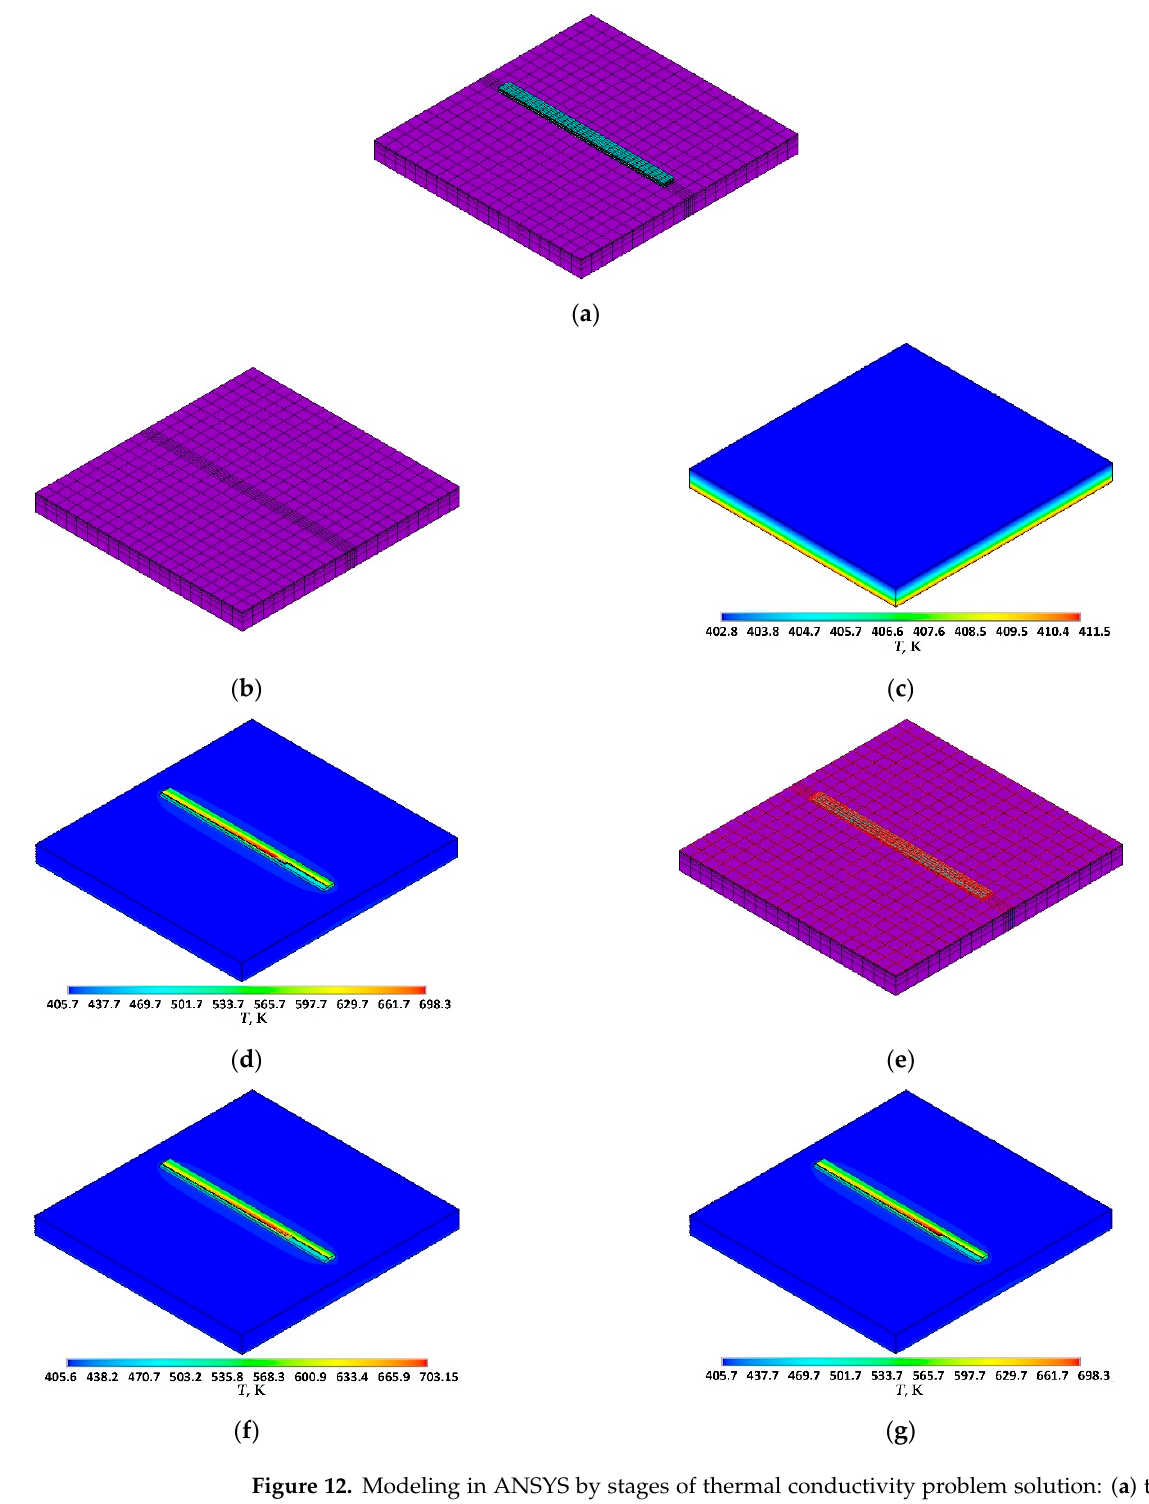
Figure 12. Modeling in ANSYS by stages of thermal conductivity problem solution: ( a ) the finite element model; ( b ) calculated scheme after “killing” the elements; ( c ) initial conditions applied to the platform before the deposition of the plate material; ( d ) “aliving” of new zone of plate elements at the k-th stage of deposition (gray zone); ( e ) setting the conditions of convective heat transfer to system at the k-th stage of deposition; ( f ) instantaneous heating of the k-th deposition zone of plate elements; ( g ) removing the heat source and waiting for the partial cooling of the system.